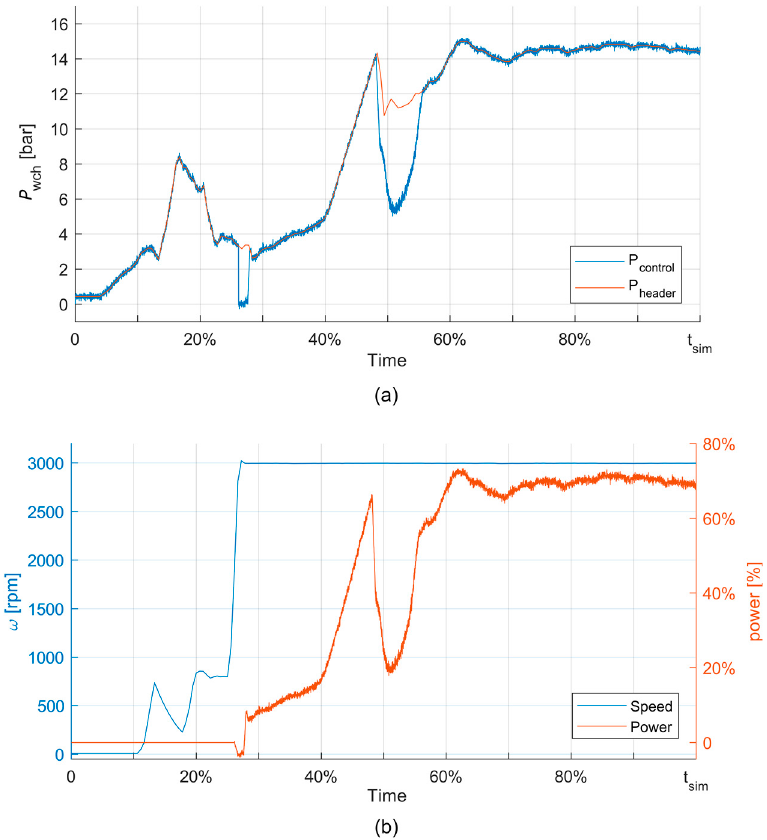
Figure 13. PI controller test, control action, generated power, and turbine speed. Header and wheel chamber pressures ( a ); rotor speed and generated power ( b ).